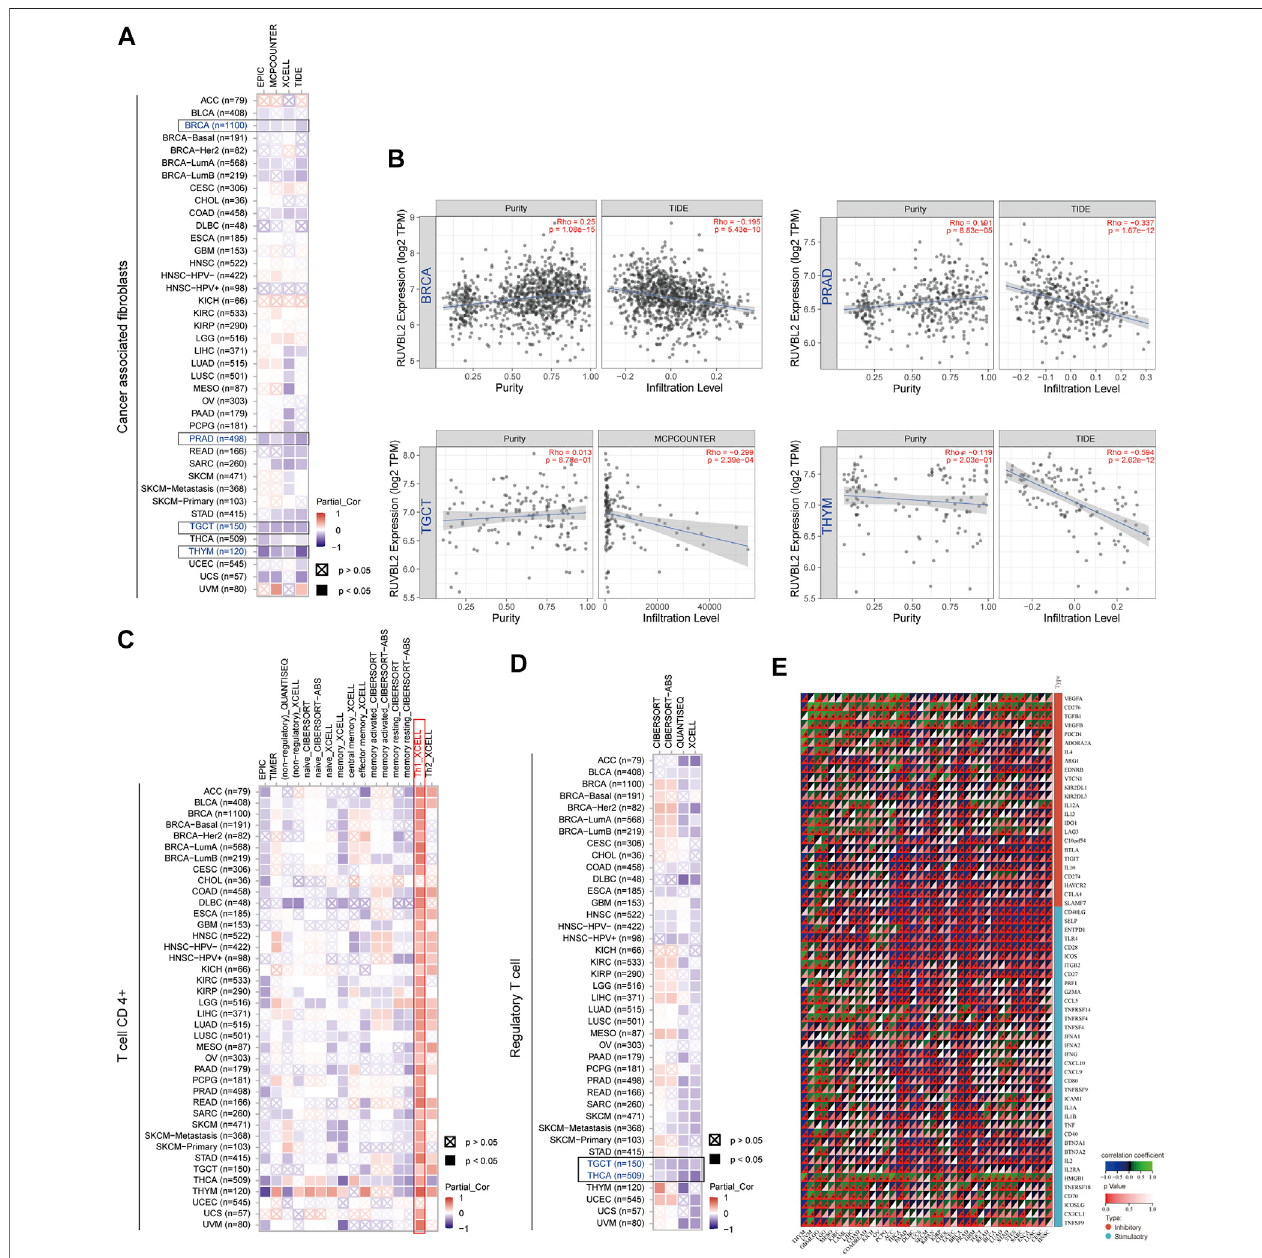
FIGURE 6 | Association between Reptin and immune cell in fi ltration across all TCGA cancers. (A) The association between Reptin and the in fi ltration of cancer- associated fi broblasts. (B) The relationship between Reptin and the in fi ltration level of cancer-associated fi broblasts in BRCA, PRAD, TGCT, and THYM. (C) The correlationbetweenReptinandthein fi ltrationofCD4 + Tcell. (D) ThecorrelationbetweenReptinandthein fi ltrationofregulatoryTcell. (E) ThecorrelationbetweenReptin and immune modulator genes in pan-cancer. * p < 0.05, ** p < 0.01, *** p <